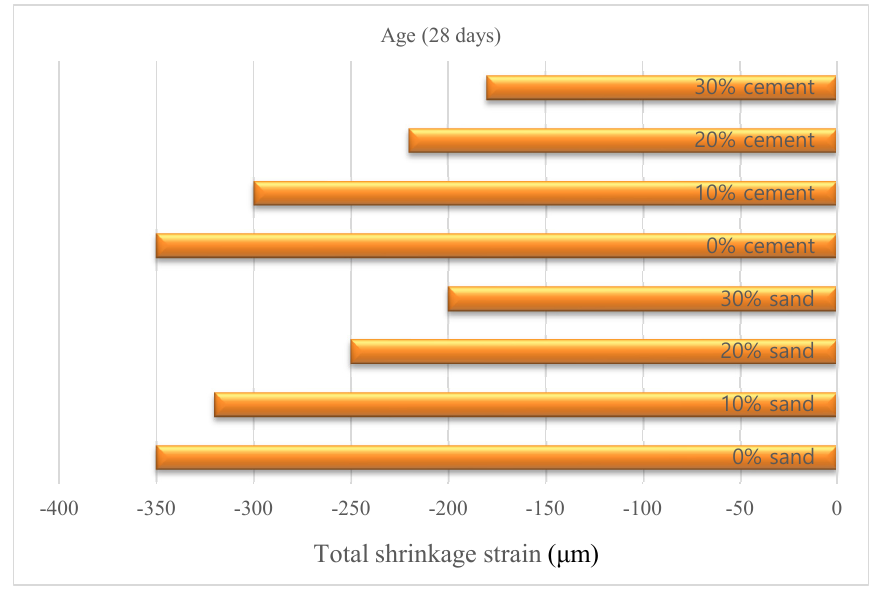
Figure 5. Total shrinkage strain based on Ref. [37].